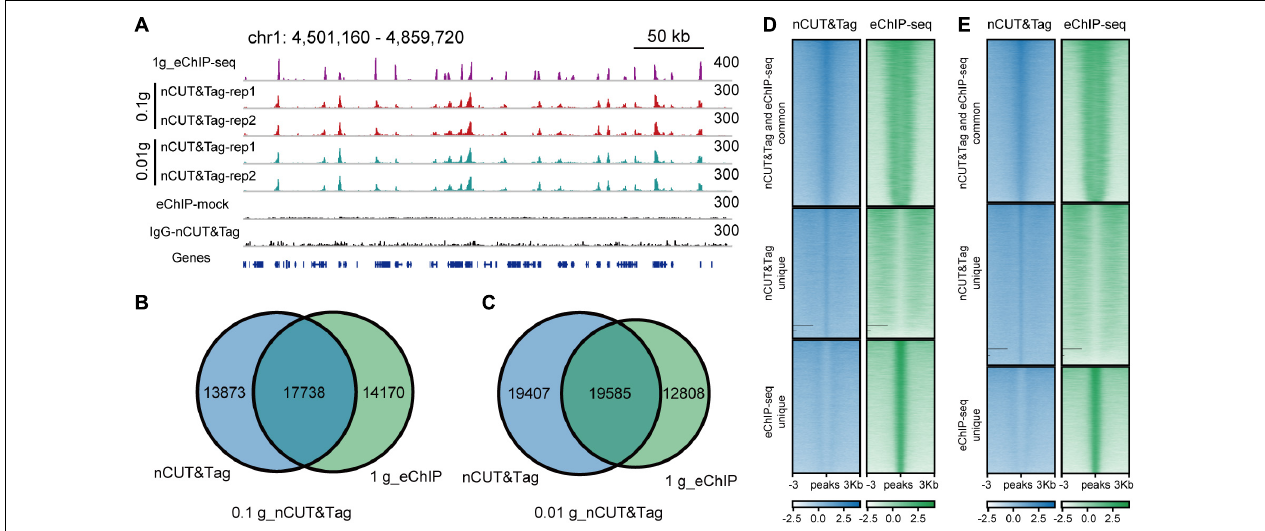
FIGURE 5 | nCUT&Tag for chromatin landscape profiling with low-input samples. (A) Genome browser screenshot showing H3K4me3 nCUT&Tag data for low-input rice seedlings. The H3K4me3 eChIP-seq data were generated with 1-g crosslinked seedlings. (B) Venn diagram showing the overlap of H3K4me3 peaks detected by 0.1-g nCUT&Tag and crosslinked eChIP-seq. (C) Venn diagram showing the overlap of H3K4me3 peaks detected by 0.01-g nCUT&Tag and crosslinked eChIP-seq. (D) Comparison of H3K4me3 signals between 0.1-g nCUT&Tag and 1-g eChIP-seq. (E) Comparison of H3K4me3 signals between 0.01-g nCUT&Tag and 1-g eChIP-seq.